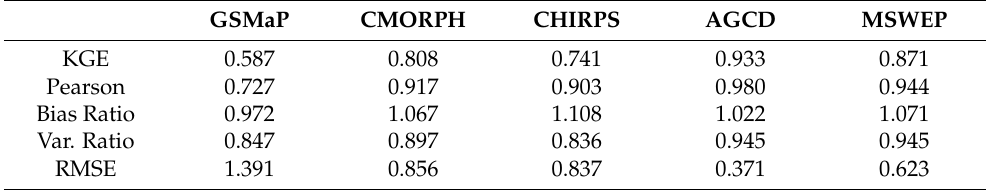
Table 2. Median KGE (as well its components), along with the RMSE, across the study period.